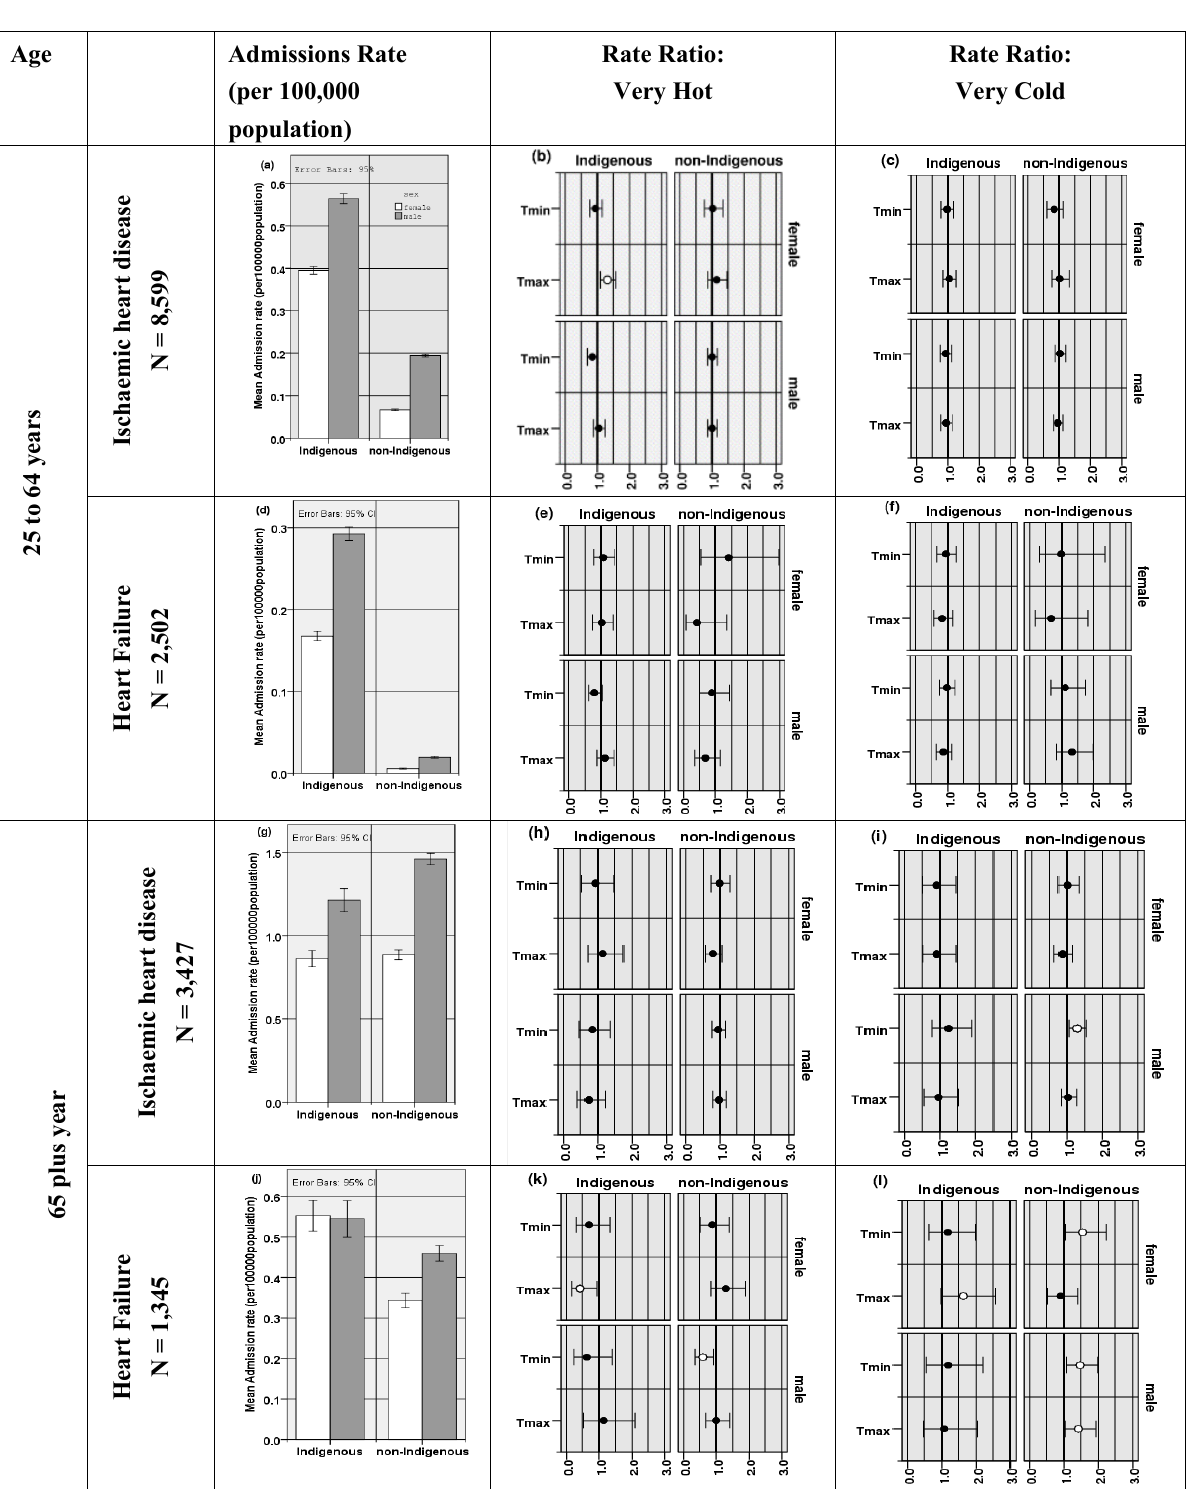
Figure 3. Northern Territory hospitals IHD and heart failure admission rates for 25 to 64 years (upper) and 65 plus years (lower). Female (white) and male (grey) are shown. Note that the scales vary in the left panel. Female and male, Indigenous and non-Indigenous Rate ratio plots for T and T are shown for very hot (mid panel) and max min very cold days (right panel) with significant effects depicted by an open circle. 95% confidence intervals are